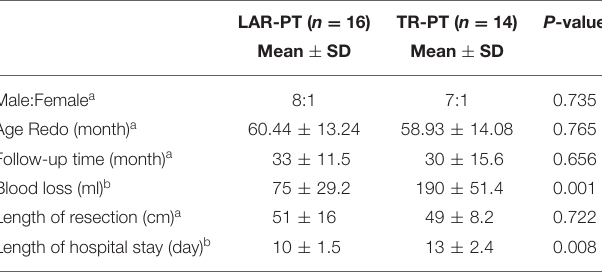
TABLE 1 | Information and surgical features of